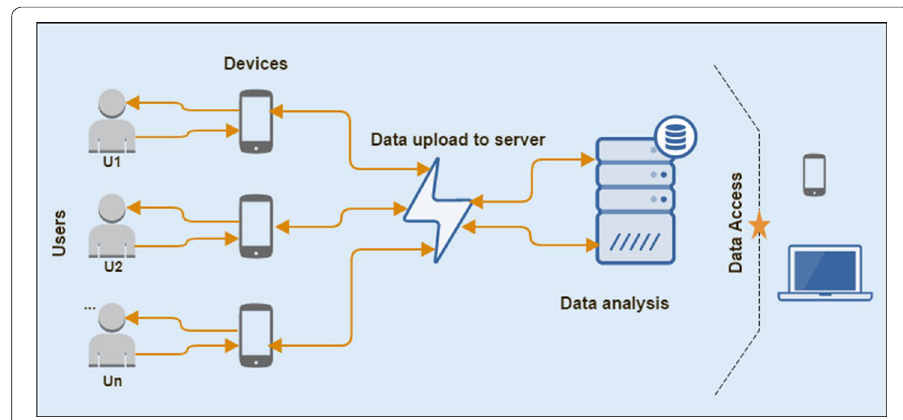
Fig. 2 Data gathering process